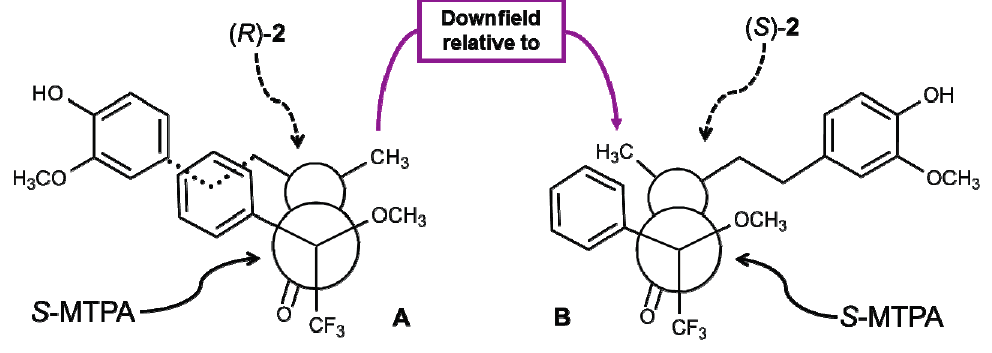
Figure 4. Configuration correlation model for ( S )-MTPA esters of ( R )- 2 ( A ) and ( S )- 2 ( B